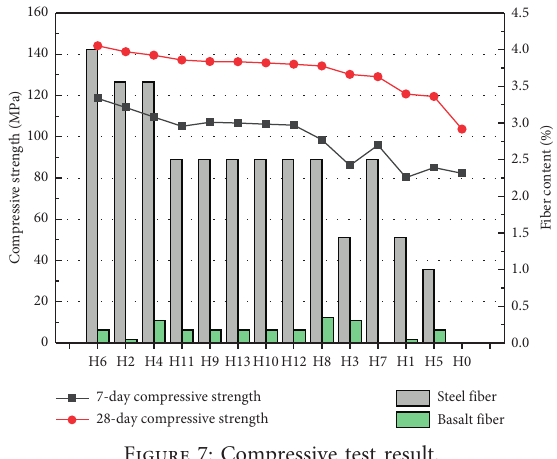
Figure 7: Compressive test result.